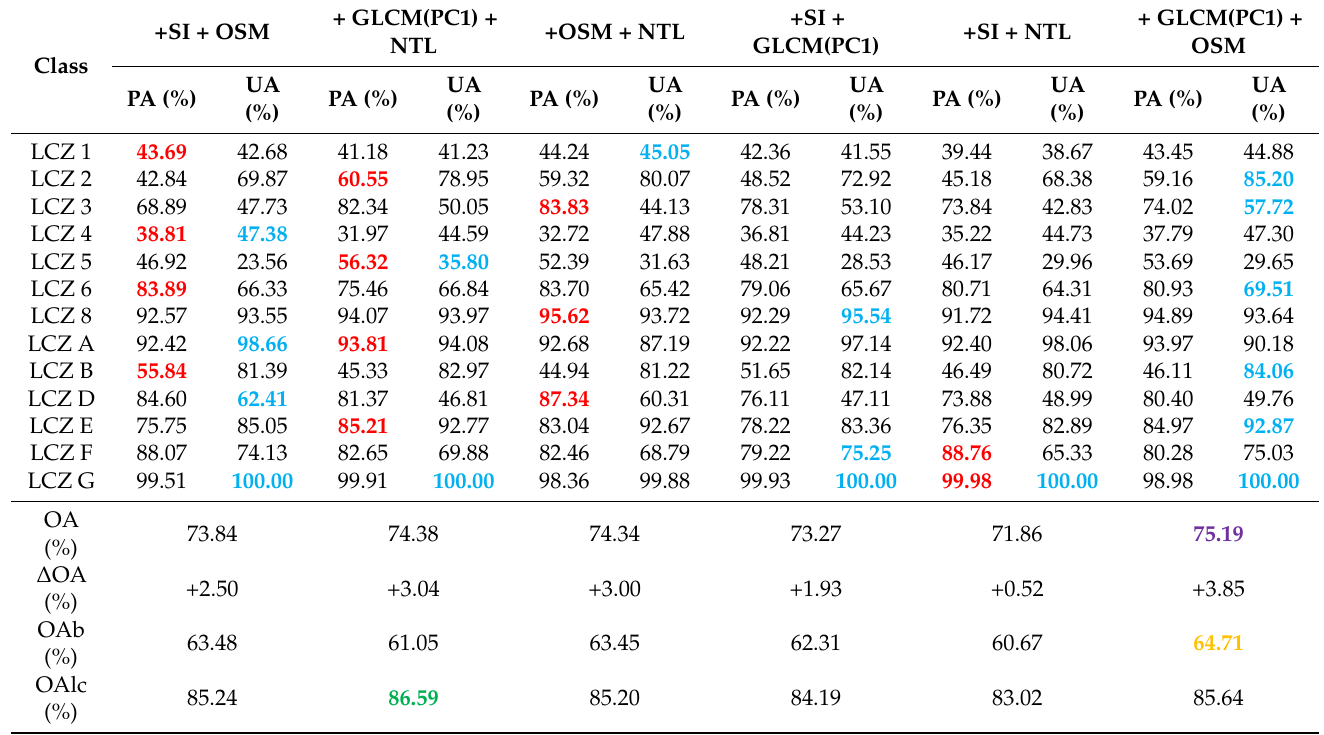
Table 7. The accuracy comparison of adding any two of secondary datasets.